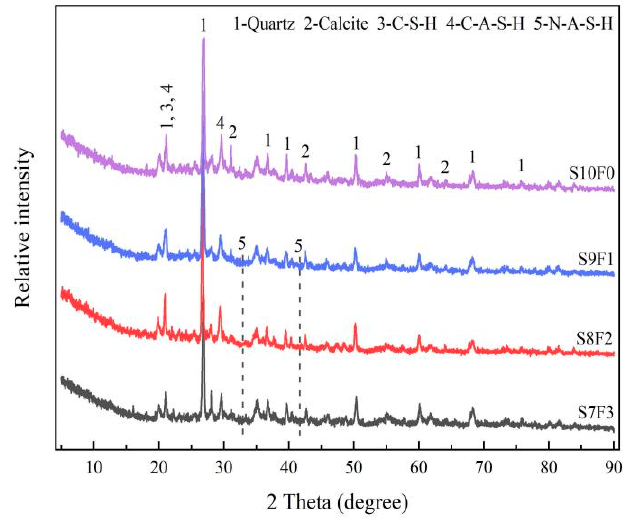
Figure 8. XRD analysis of SF-GSSS before sulfate attack.